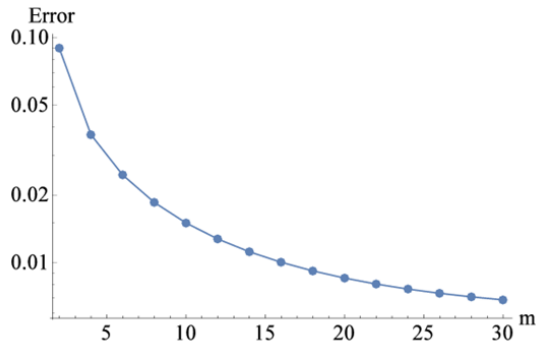
Figure 2. Total square residual sum of the problem.